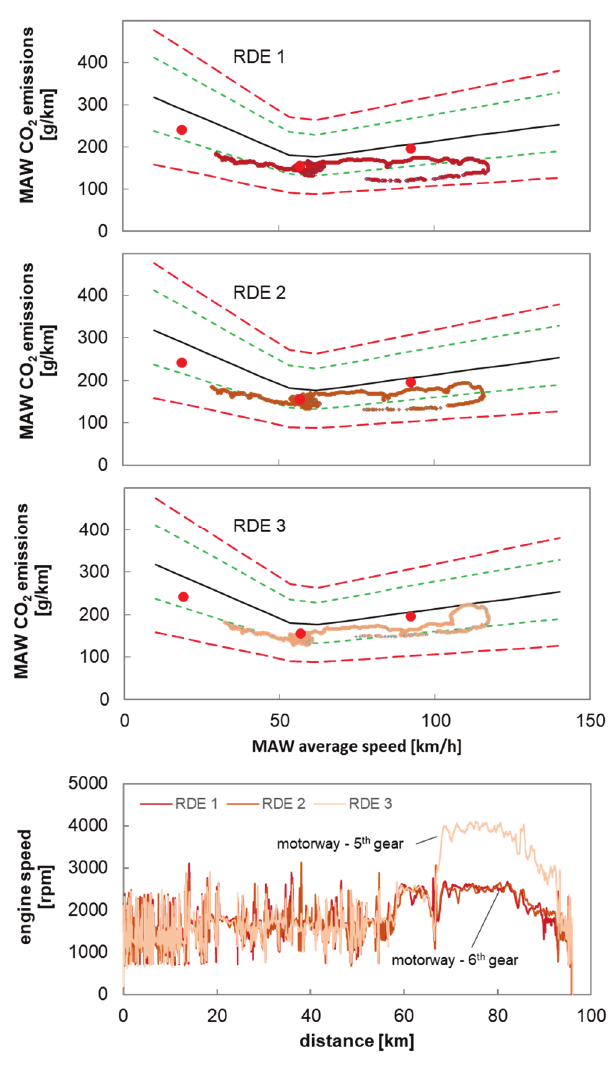
Fig. 11. RDE normality results and vehicle engine speed; Volvo